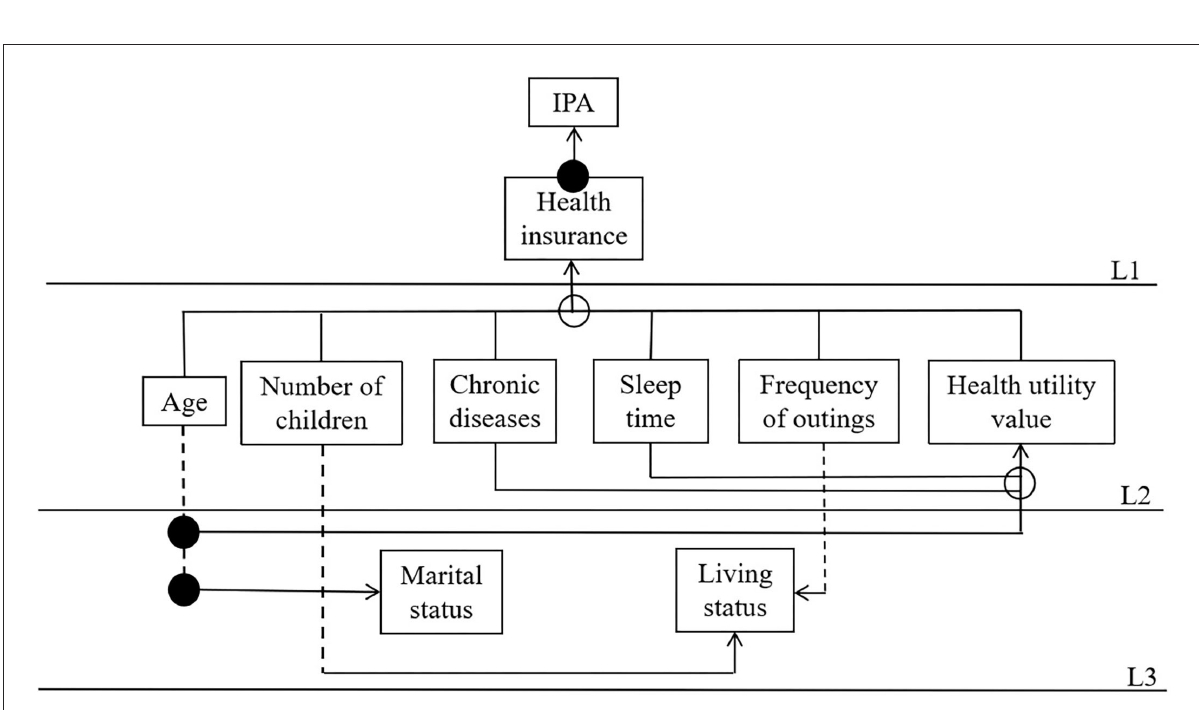
FIGURE5 Interpretative structural model of influencing factors. A solid line indicates direct influence, a dashed line indicates cross-level influence, a solid dot indicates two related influence lines, and a hollow dot indicates three or more influence relationships.